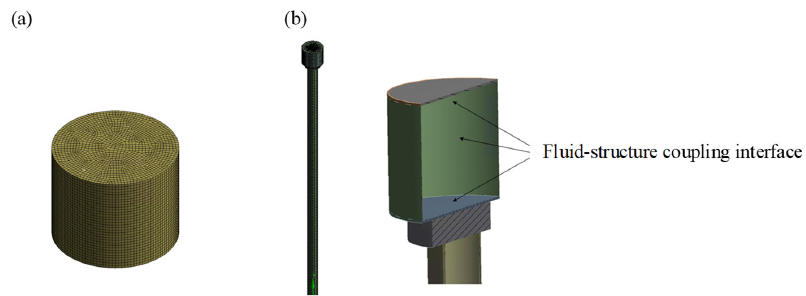
Figure 10. ( a ) The mesh arrangements of fluid in TLD and ( b ) the fluid–structure coupling interface.